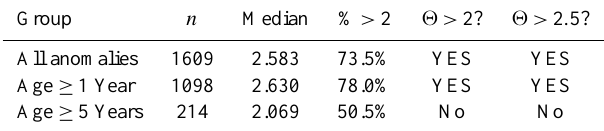
Table 3. Analysis of the distribution of the maxium perceived-to- actual age ratios (of the eight calculated for each anomaly) broken down by all anomalies (top row), anomalies occuring on satellites one year of age and older (center row), and anomalies occuring on satellites five years of age and older (bottom row). Number of events, medians, and the percent of the distribution that falls to the right of 2 is shown. The two right-most columns report if the sam- ple represents a parent population whose medians are greater than 2 or 2.5 (99% confidence